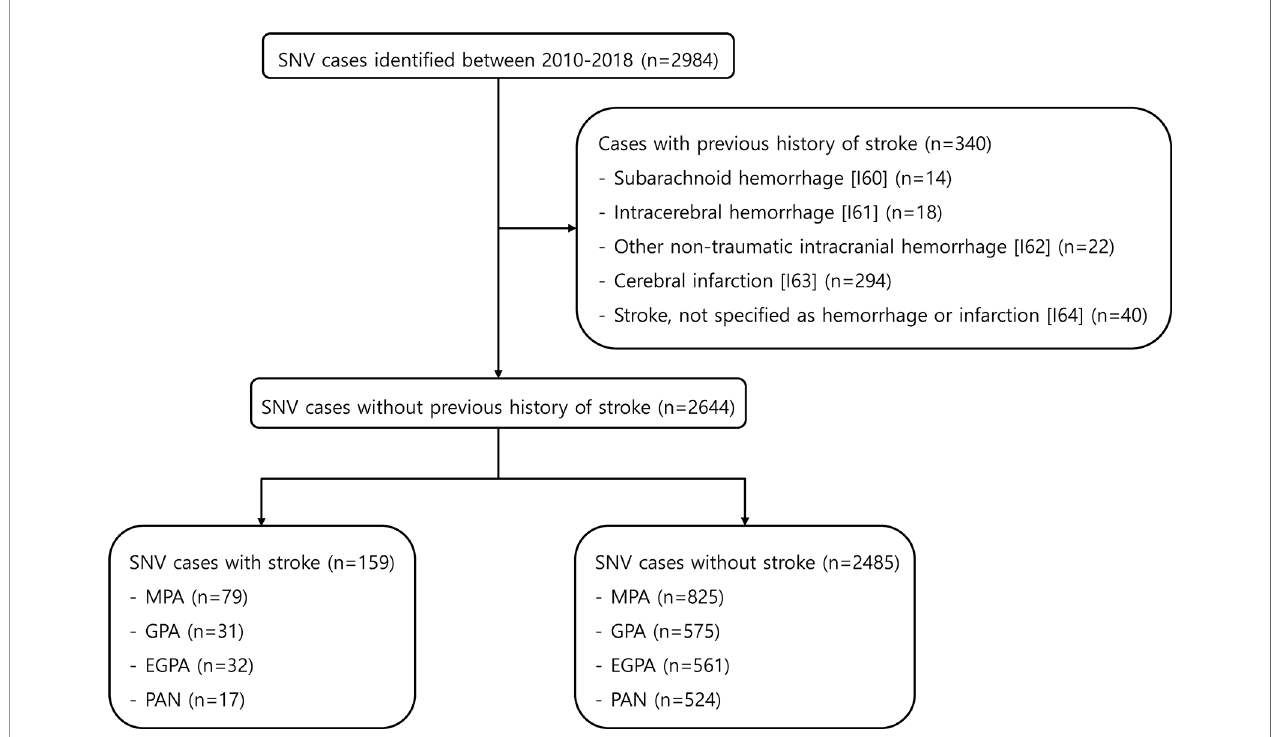
FIGURE 1 | Selection of the study population from the HIRA database. HIRA, Health Insurance and Review Agency; SNV, systemic necrotizing vasculitis; MPA, microscopic polyangiitis; GPA, granulomatosis with polyangiitis; EGPA, eosinophilic granulomatosis with polyangiitis; PAN, polyarteritis